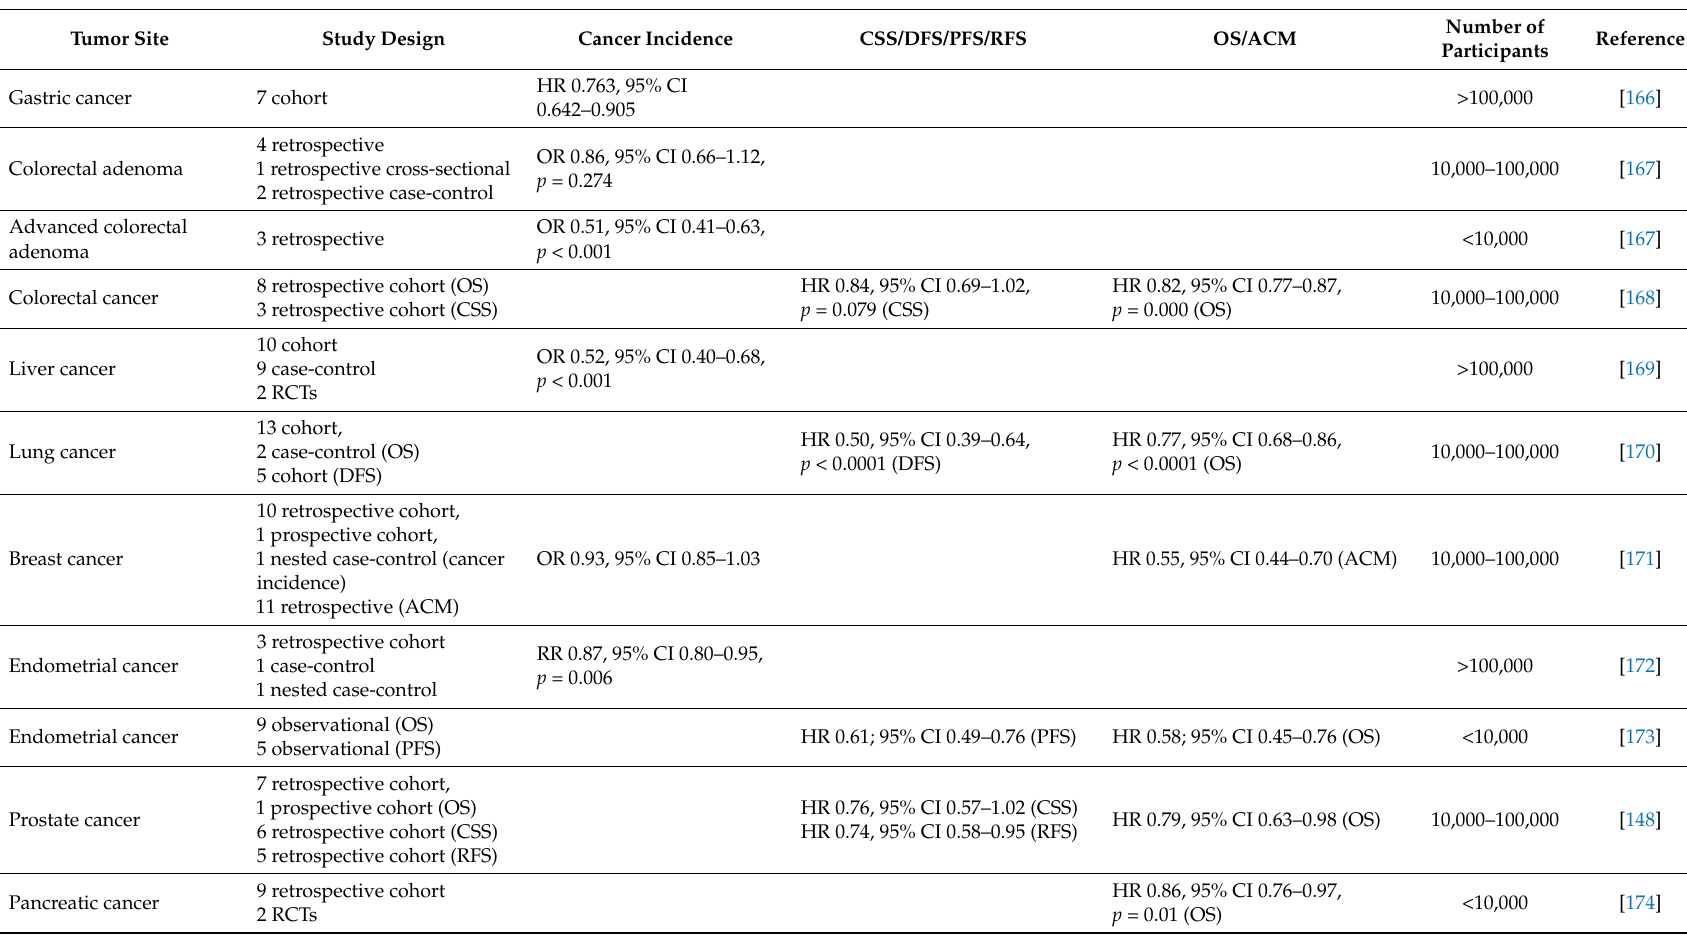
Table 1. Meta-analyses of MTF effects on cancer-site-specific incidence and